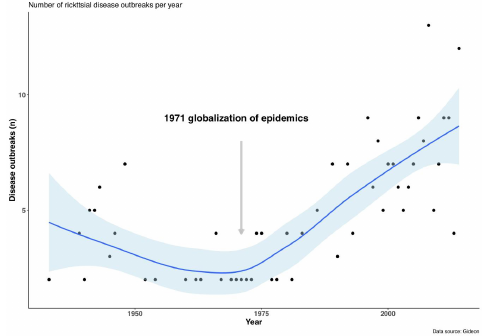
Figure 1. Trends in outbreaks of rickettsial diseases per year from 1920 to 2016, with significant increase in the number of outbreaks since 1971 (using the package ‘segmented’ [24]). Data on rickettsial disease outbreaks were obtained from the GIDEON database (see Section 2).